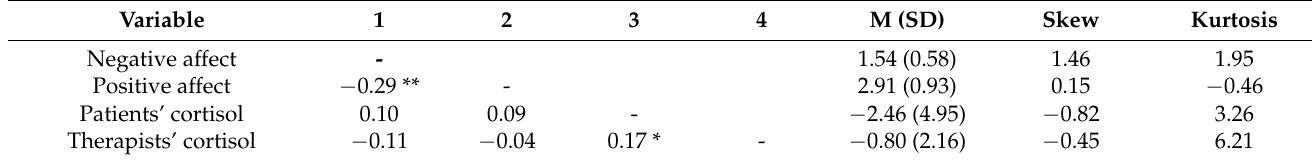
Table 1. Means, standard deviations, intercorrelations and distribution of variables.